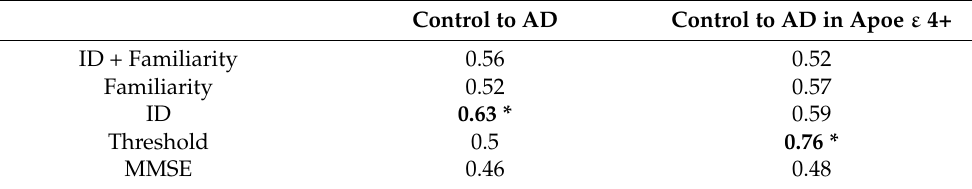
Table 3. AUC values for odor measures and MMSE: Cognitively normal controls converting to